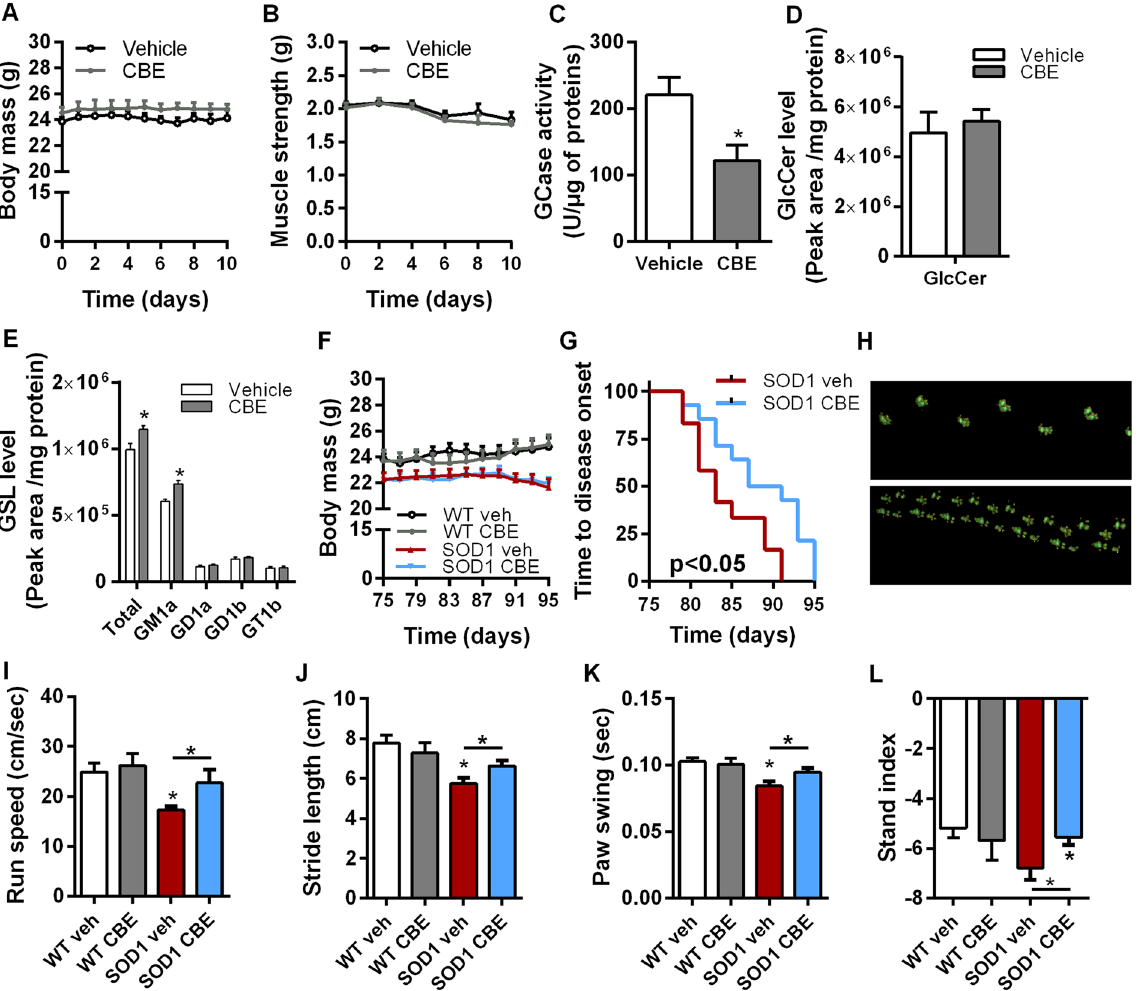
Figure 2. Pharmacological inhibition of GCase activity delays disease onset and improves motor functions in SOD1 G86R mice. ( A ) Body mass evolution in wild type mice after 10 days of CBE treatment (n = 5/group). ( B ) Muscle strength of wild type mice after 10 days of CBE treatment (n = 5/group). ( C ) Total β -glucocerebrosidase activity measured in the spinal cord lysate of wild type mice (n = 5). ( D , E ) GlcCer ( D ) and gangliosides ( E ) levels in the spinal cord of wild type mice after CBE treatment (n = 5/group). ( F ) Body mass evolution in SOD1 and WT mice (n = 7 for WT groups, n = 12 for SOD1 veh and n = 14 for SOD1 CBE). ( G ) Kaplan-Meier showing time to onset of muscle strength loss in SOD1 G86R mice (n = 12 for SOD1 veh and n = 14 for SOD1 CBE, p < 0.02). ( H – L ) Catwalk analysis showing representative pattern of strides of symptomatic SOD1 G86R mice ( H ), and average speed ( I ), stride length ( J ), paw swing ( K ) and stand index ( L ) in 95 days old mice. Mean ± SEM, * p <